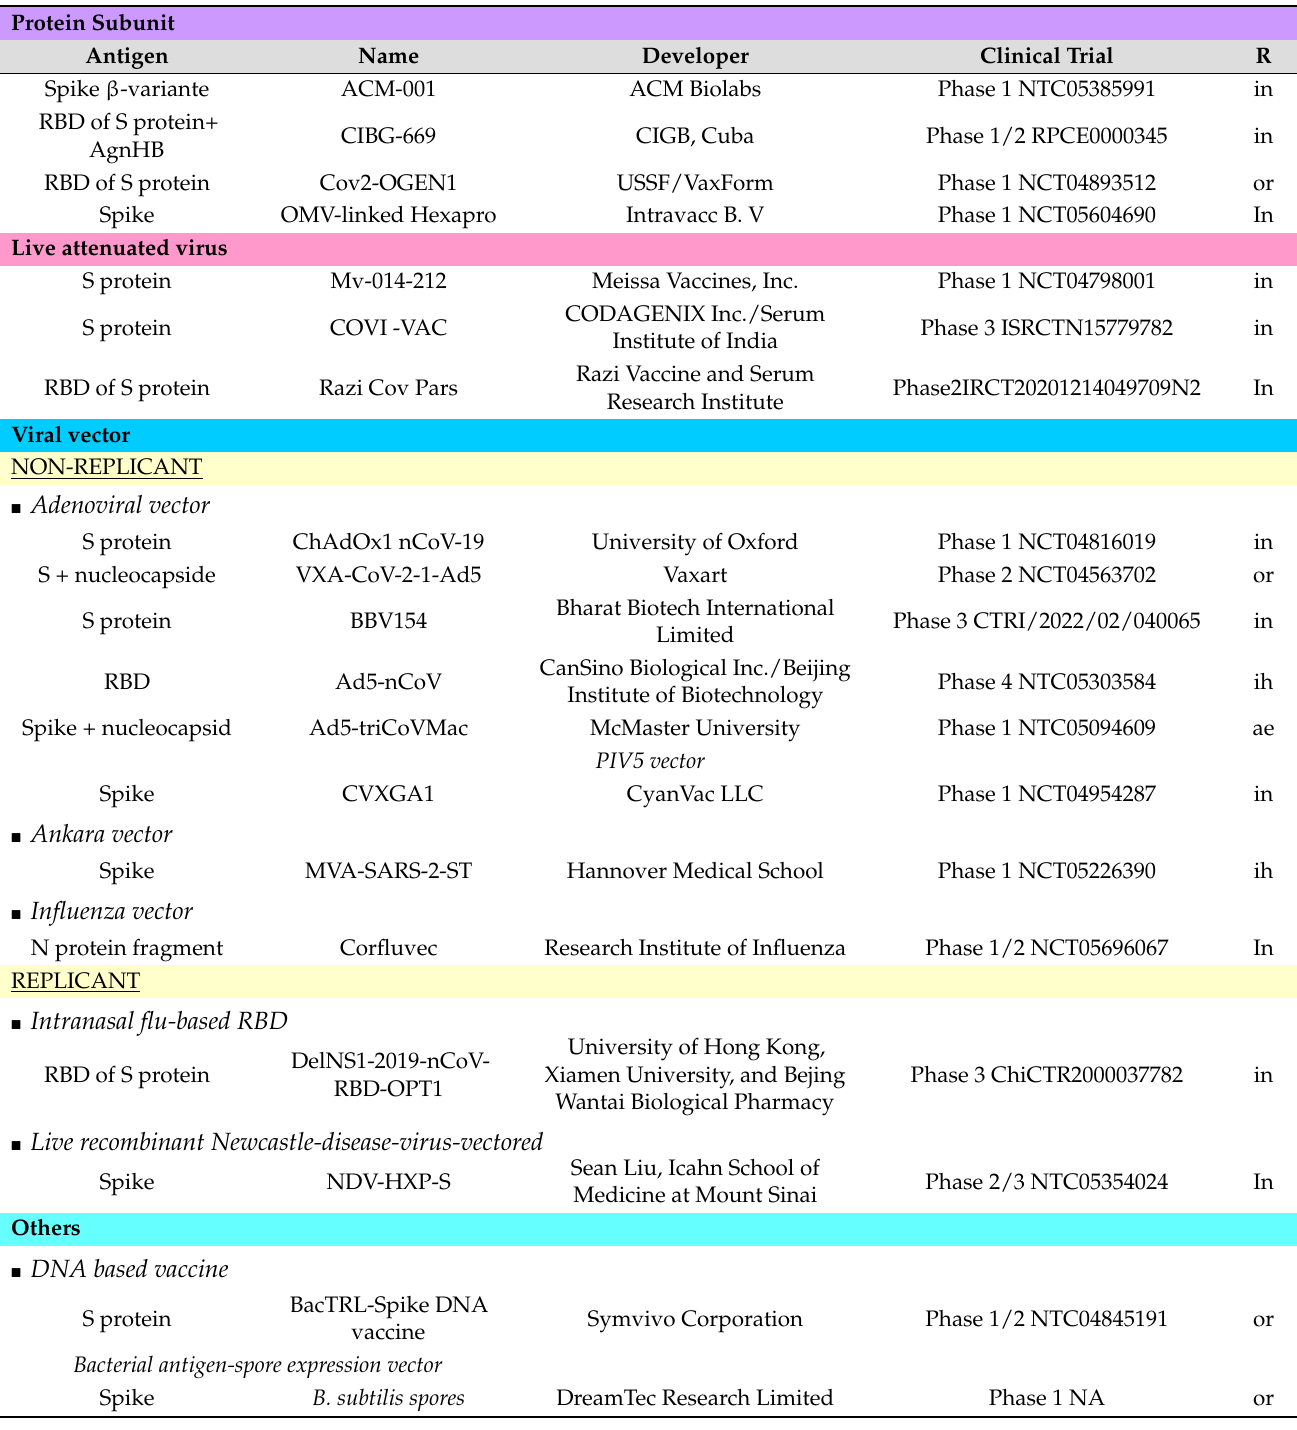
Table 1. Current mucosal COVID-19 vaccine candidates in clinical trials. Adapted from WHO vaccine tracker and landscape, February 2023 (Available online: https://www.who.int/publications/ m/item/draft-landscape-of-COVID-19-candidate-vaccines, accessed on: 10 February 2023). RBD, receptor-binding domain; Ad, adenovirus; MVA, modified vaccinia Ankara; LAIV, live attenuated influenza virus; NDV, Newcastle disease virus. R , route of administration: in, intranasal; or, oral; ae, aerosol; ih,